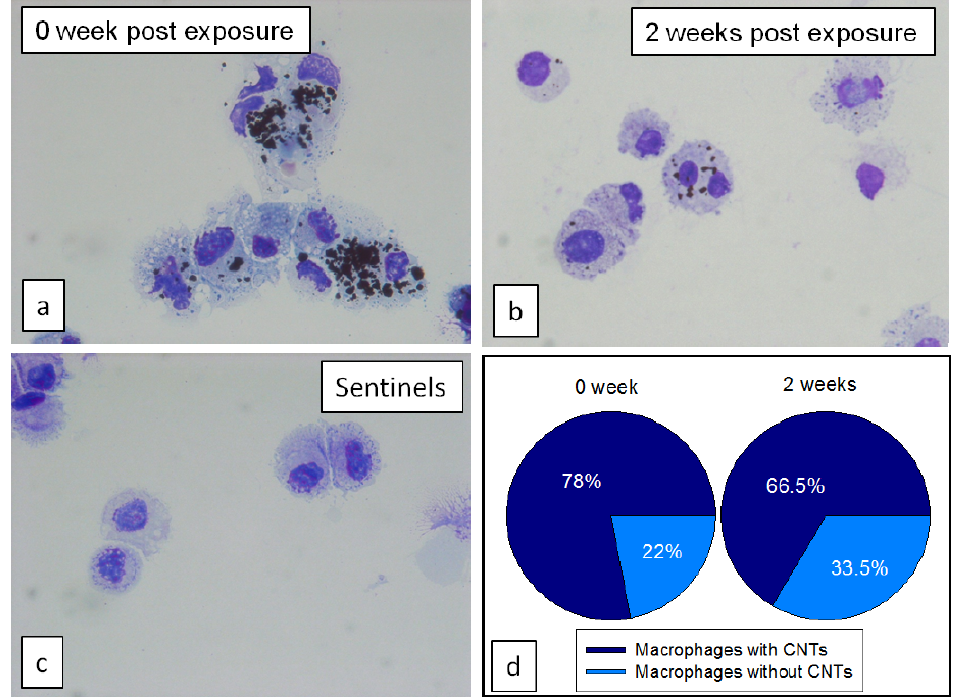
Figure 8. BAL macrophages from mice necropsied ( a ) immediately; or ( b ) 2 weeks after last exposure to CNTs; and ( c ) from control mice without exposure; ( d ) Pie charts represent percentage of macrophages population with and without